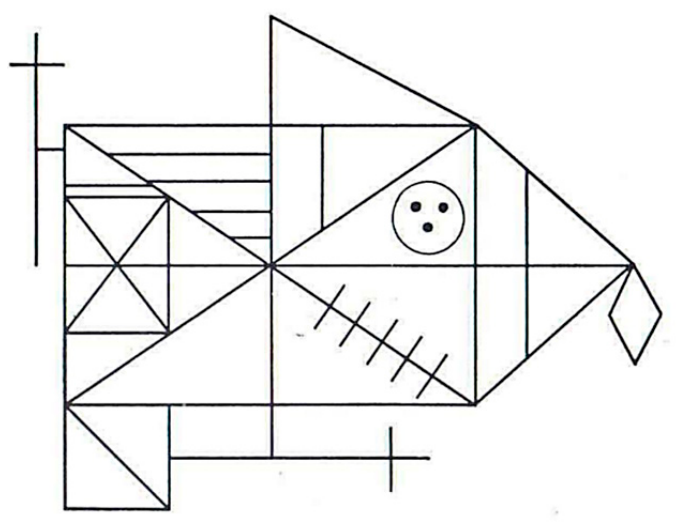
Figure 6. An abstract drawing replica in the Rey–Osterrieth Complex Figure Test (ROCFT).